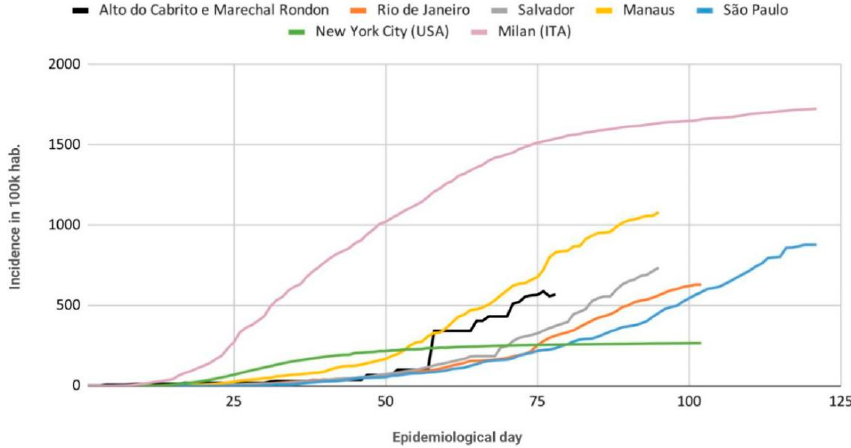
Figure 5. Confirmed COVID-19 cases in Salvador, in the study area, and in other cities. Sources